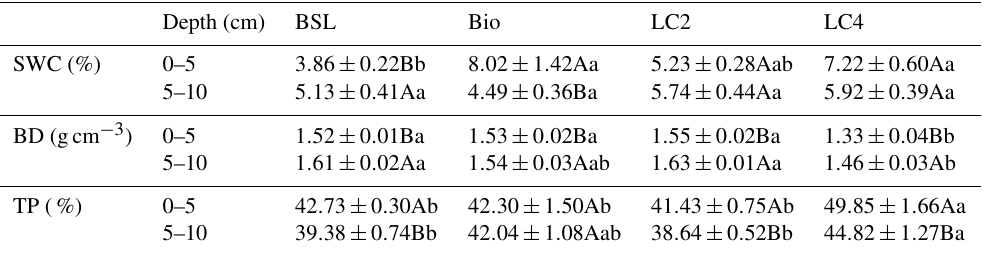
Table 1. Soil water content and bulk density (mean ± SE) at the 0–10cm soil layer depth with different crust types. SWC, soil water content; BD, bulk density; TP, soil total porosity; BSL, bare sandy land; Bio, moss crust; LC2, litter crust for 2 years; LC4, litter crust for 4 years. Different lowercase letters indicate significant differences among the various crust soils at the level of p< 0 . 05, and different uppercase letters indicate significant differences among different depths at the level of p< 0 . 05. Depth (cm) BSL Bio